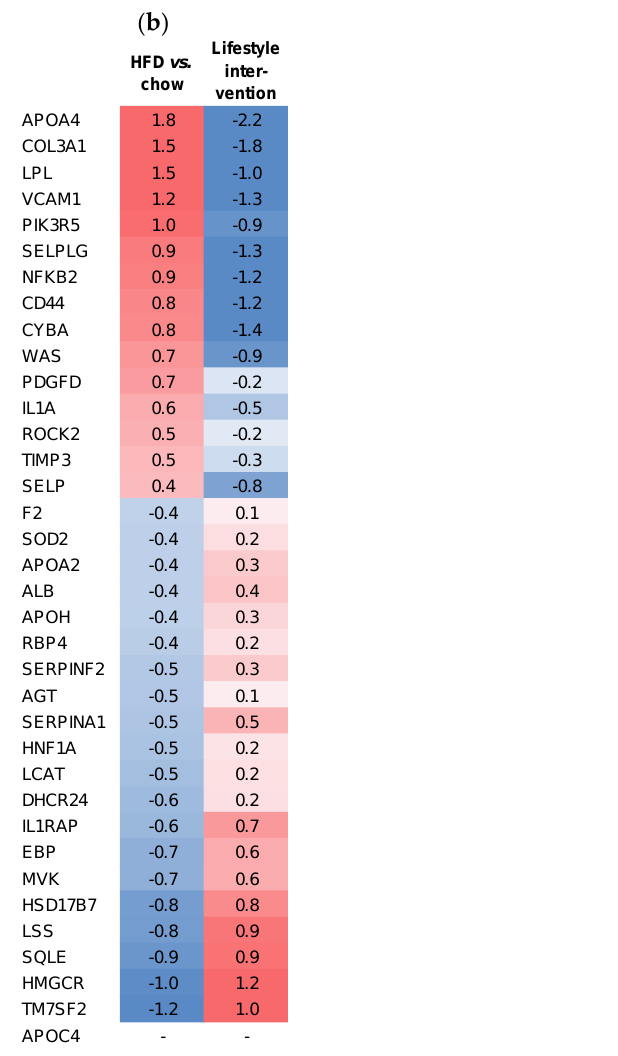
Figure 3. Diagram revealing the association of dynGENIE3 identified key regulators and pathways based on the differentially expressed genes of Ldlr−/−.Leiden mice fed a high-fat diet (HFD) for 6, 12, 18 and 24 weeks ( n = 15 per time point) vs. mice fed a healthy chow diet ( n = 6 per time point) in liver (source) and aorta (target). Two separate dynGENIE3 analyses were performed, shown here in grey and red connecting lines in one overlay figure ( a ). Hepatic key regulators were validated in a second independent study using Ldlr−/−.Leiden mice fed the high-fat diet (HFD) for 30 weeks, followed by a lifestyle intervention (switch to healthy chow diet combined with voluntary exercise) for another 20 weeks. Heatmap shows the expression of the hepatic key regulators ( b ). Cut-off values of 2logFC < −0 .4 and >0.4 for HFD vs. chow were used. Blue color indicates downregulation and red color indicates upregulation.